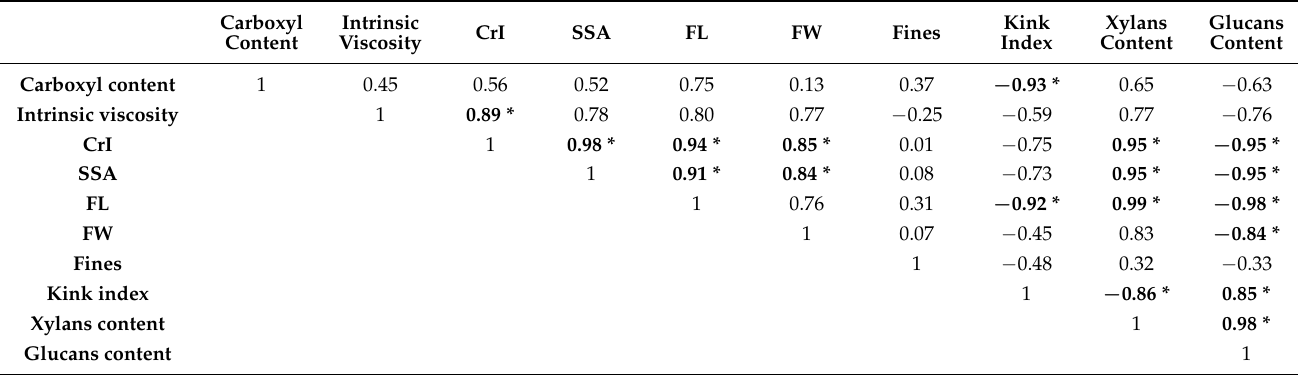
* Indicates significant correlation at p < 0.05. Table 3. Pearson correlation index between evaluated variables of the pine samples. n =